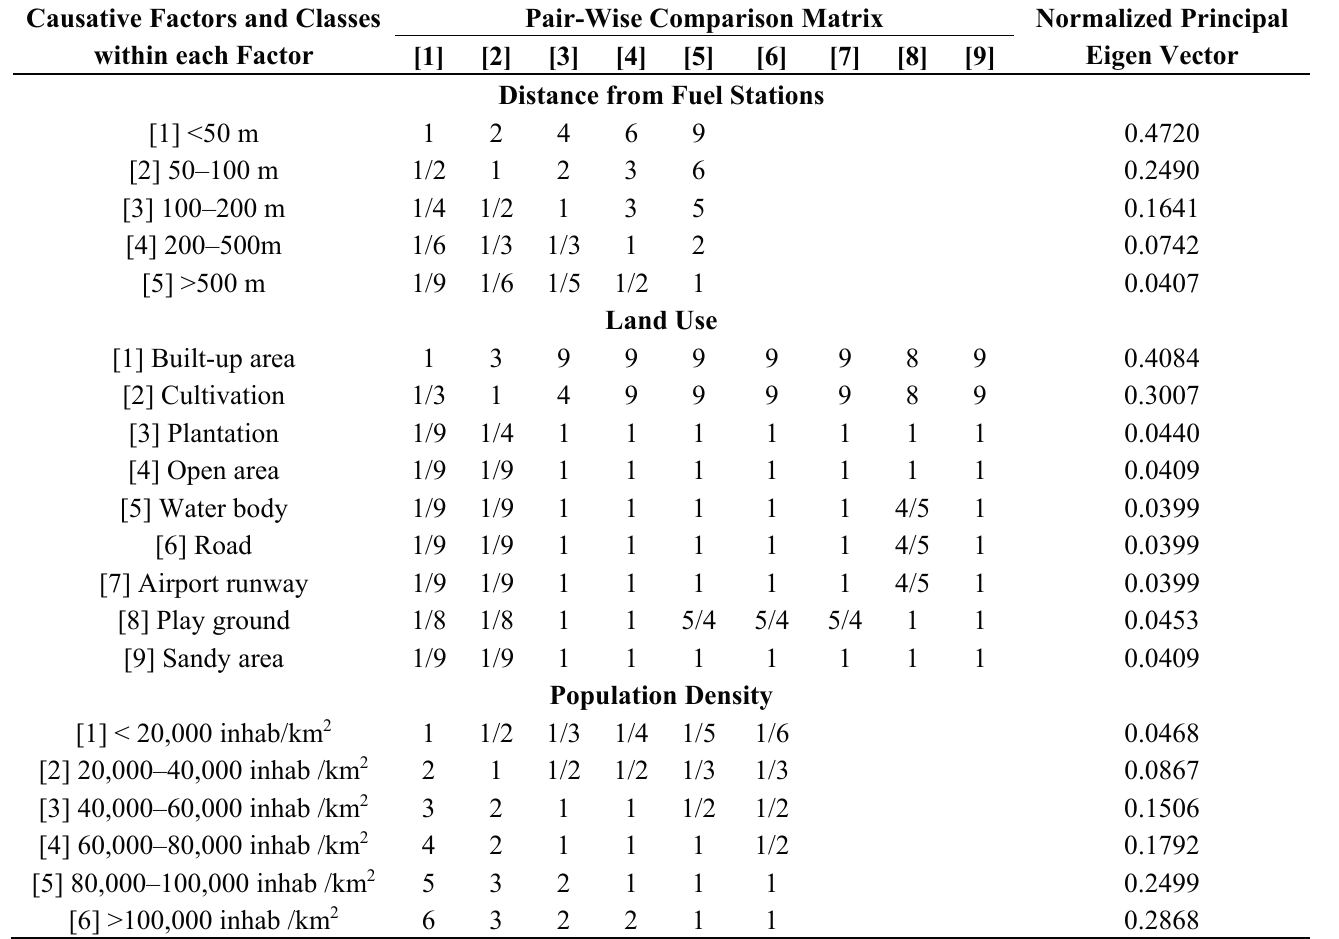
Table 4. Pair-wise comparison matrix and normalized principal eigenvector for the classes within each causative factor of fire potential, as required for applying the AHP